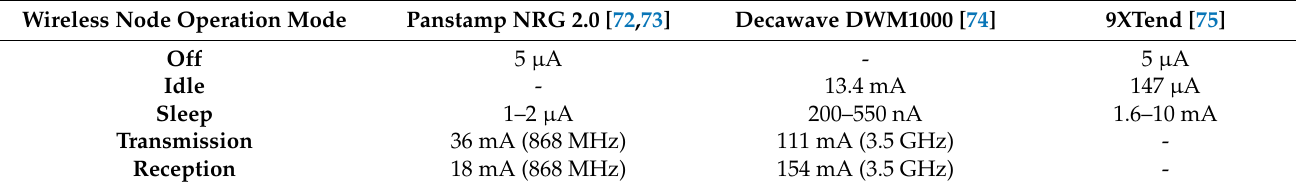
Table 2. Drained current of different wireless sensor node for different activity